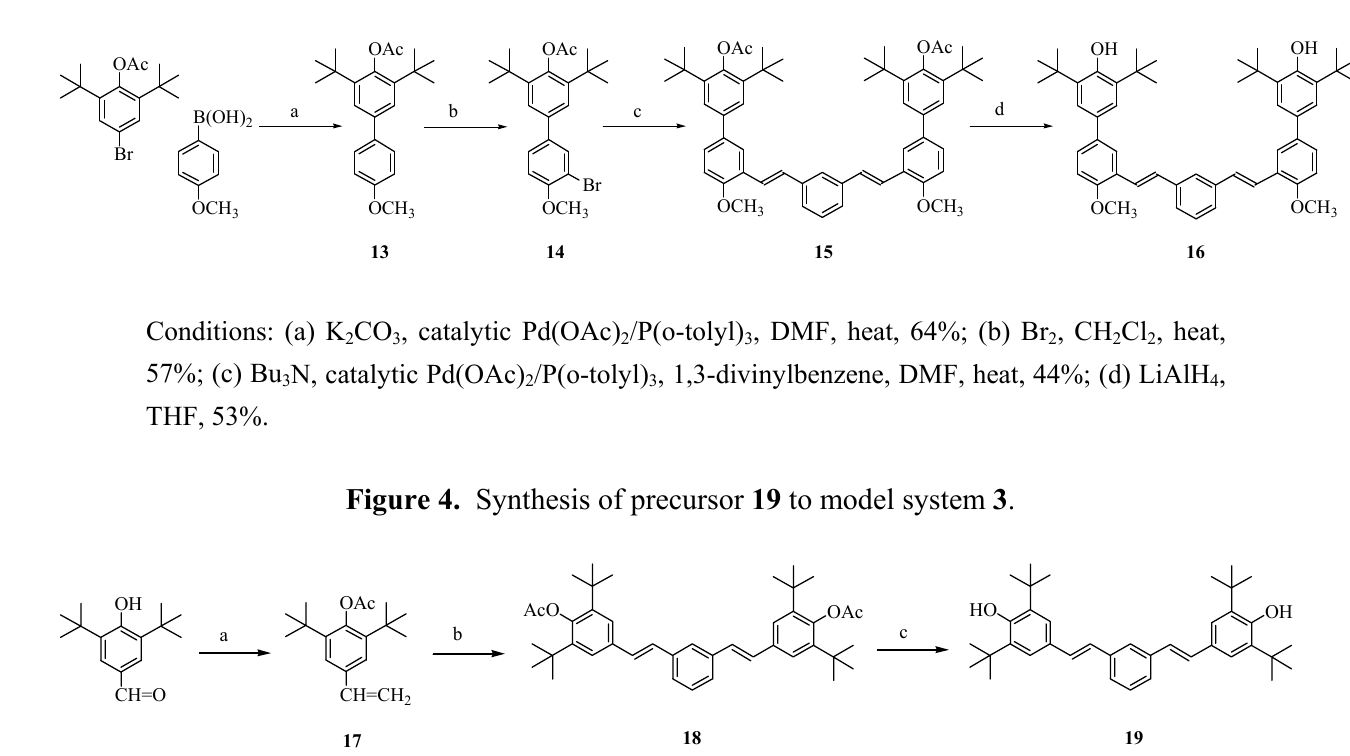
Figure 3. Synthesis of precursor 16 to model system 1 .